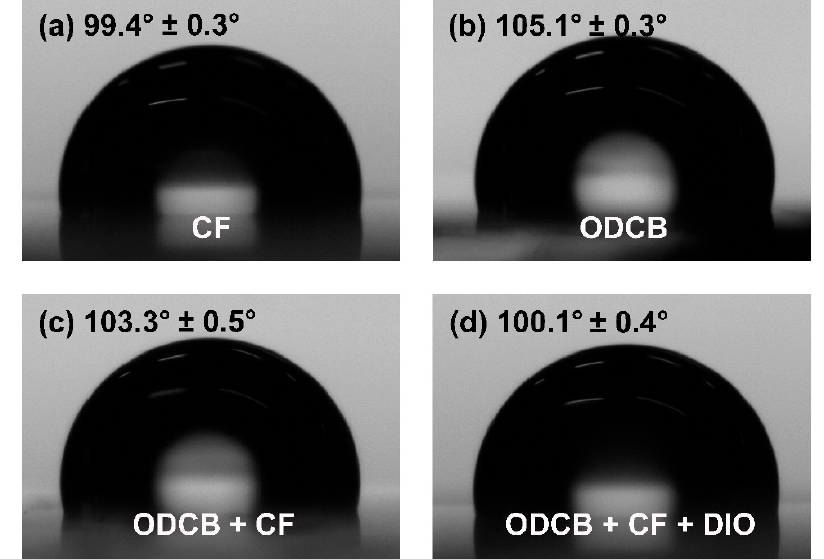
Figure 6. Water contact angle images of the top surface of ( a ) active-layer film prepared by CF; ( b ) active-layer film prepared by ODCB; ( c ) active-layer film prepared by ODCB:CF (2:1); and ( d ) active-layer film prepared by ODCB:CF (2:1) with 2.5% DIO.